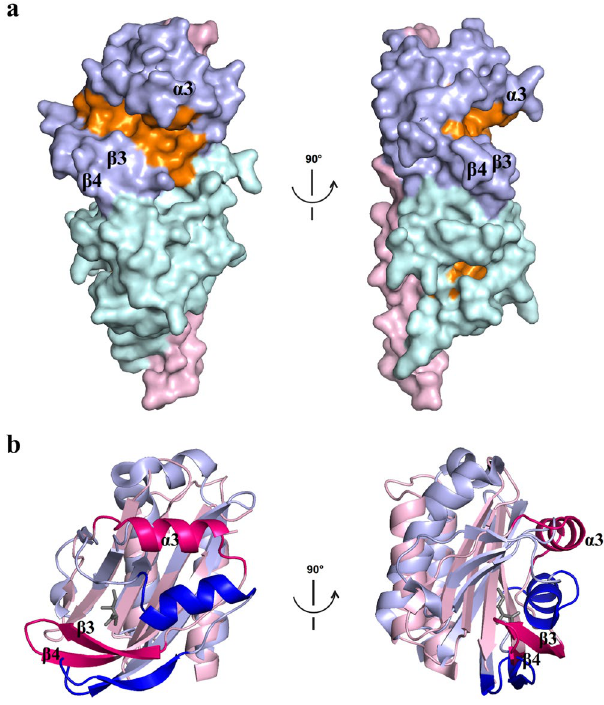
Figure 3. Putative ligand-binding sites of TlpC LBD. ( a ) Molecular surface of TlpC LBD with cavities and pockets coloured orange. The stalk helix is coloured pink, the membrane-distal module – light blue and the membrane-proximal module – cyan. ( b ) Structure superposition of membrane-distal modules of TlpC (pink) and Tlp3 (light blue) highlighting differences in position of helix α 3 and β 3- β 4-tongue (coloured hot pink and blue in TlpC and Tlp3, respectively). Isoleucine bound to the membrane-distal module of Tlp3 is shown as grey sticks.